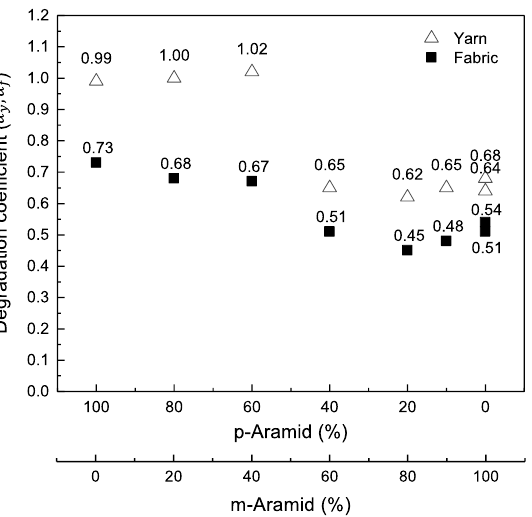
Figure 6. Relationship between the fraction of UV exposure energy and retention fraction of tensile strength of yarns and fabrics on Samples A to H. White- and black-filled symbols represent experi- mental data of yarn and fabric, respectively. The solid and dotted lines represent the fitting data of the yarn and fabric by Equation (3).